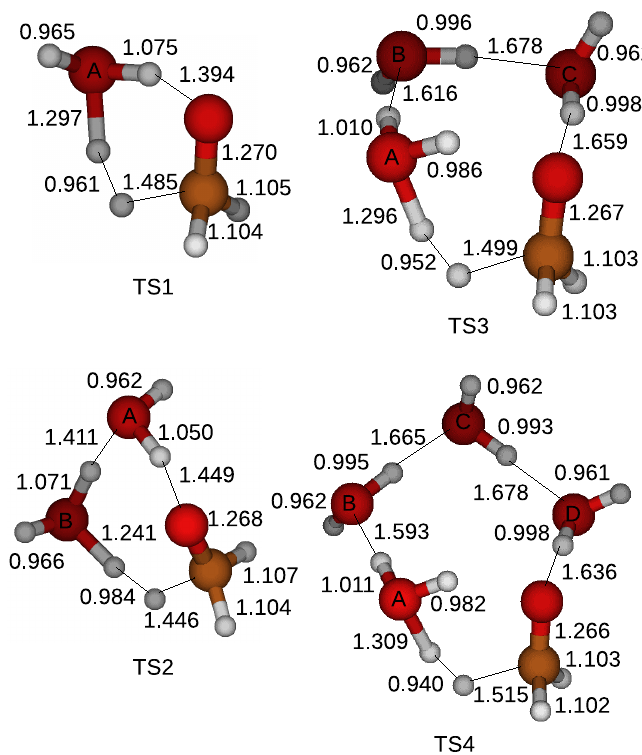
Figure 4. Optimized structures of the transition states for the oxidation of a CH and H O molecules form a ring structure. Four labels (A, B, C, D) are affixed to oxygen atoms of 2 H O molecules to distinguish. We apply the Gaussian 4 method and optimize the transition states. 2 H O molecules assist the oxidation of a CH 2 simulations. TS n stands for Transition States when the oxidation of a CH molecules in a ring